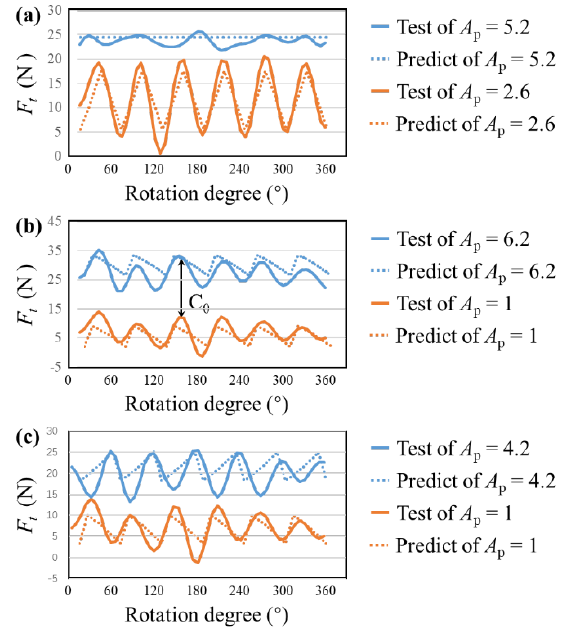
Figure 11. Enlarged view of milling force data: ( a ) enlarged view of the milling force data at A p = 2.6 mm and A p = 5.2 mm; ( b ) enlarged view of milling force data at A p = 1 mm and A p = 6.2 mm; and ( c ) enlarged view of the milling force data at A p = 1 mm and A p = 4.2 mm.